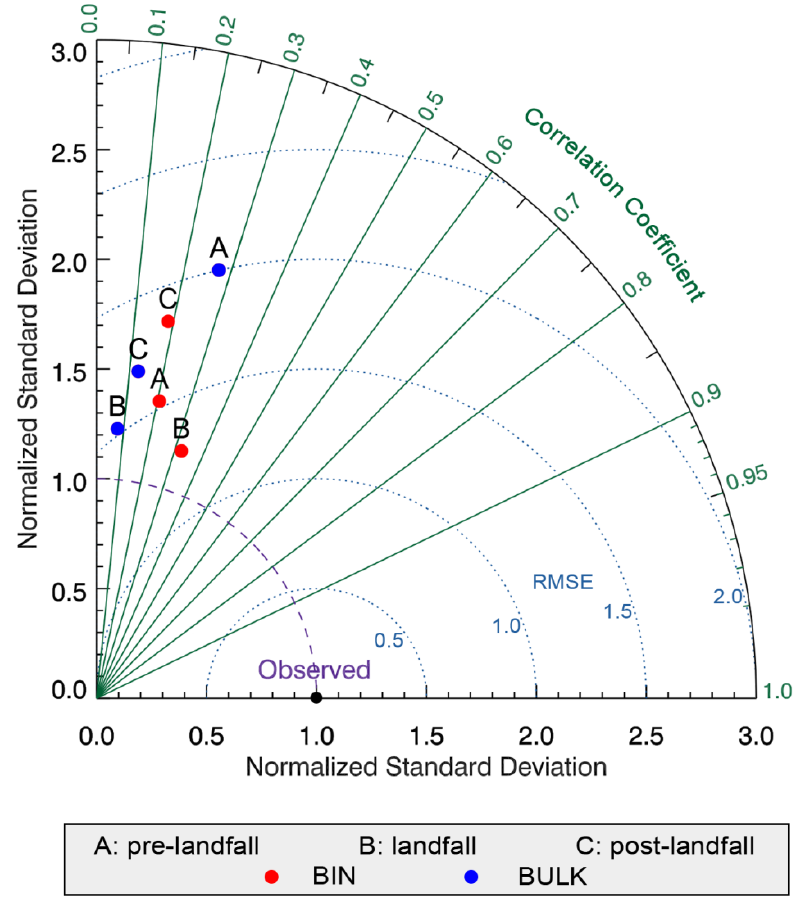
Figure 5. Taylor diagram comparing simulated brightness temperature (K) from BIN and BULK schemes at three different landing stages. The dashed purple curve represents normalized standard deviation of the observations, the dotted pale-blue curves represent the centered RMSE, and the solid pale-green lines represent correlation coefficients.